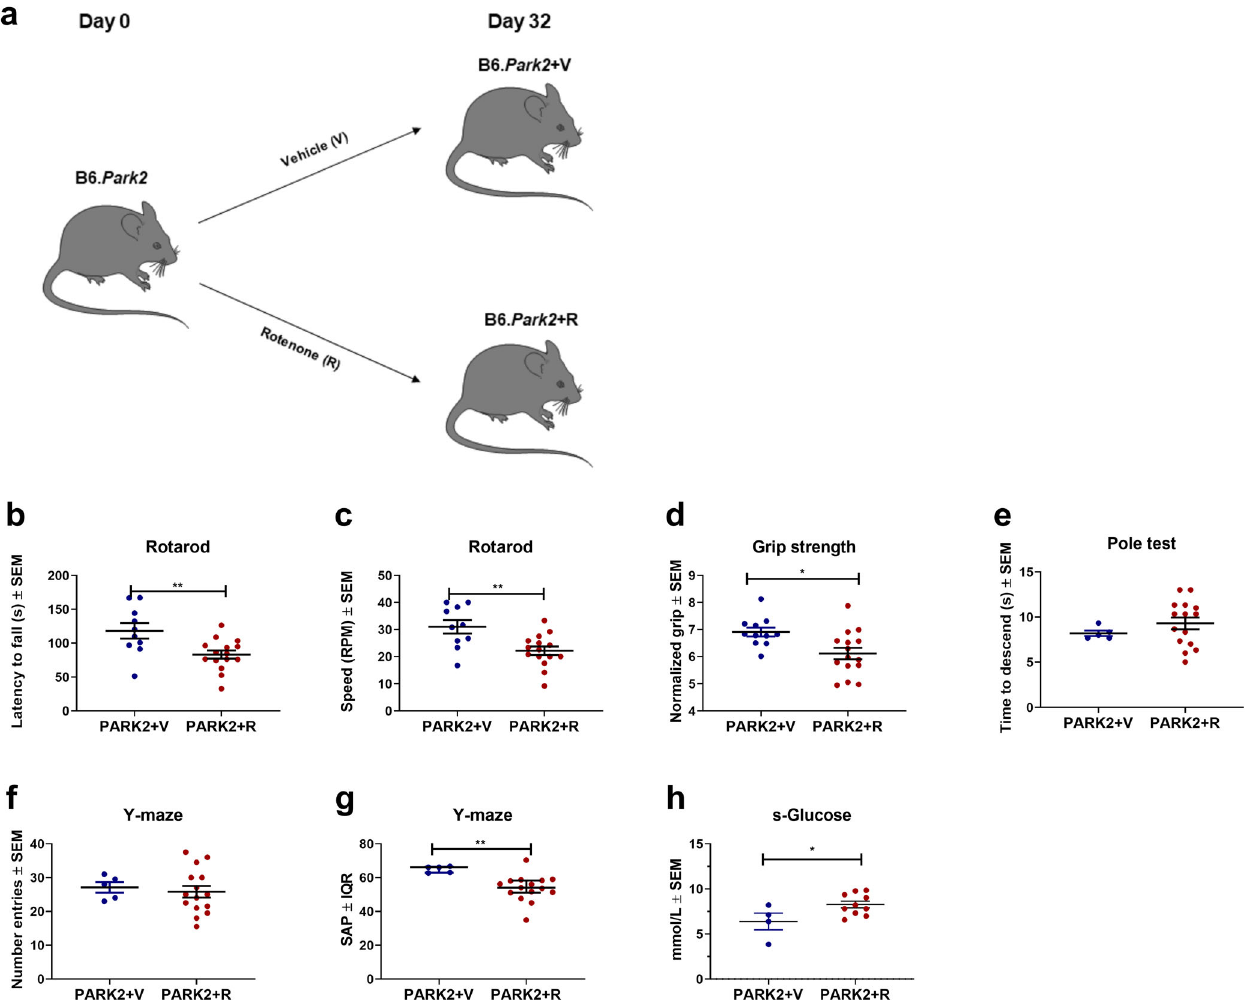
Fig. 7 Rotenone aggravates motor and non-motor dysfunction in PARK2 knockout mice. a Male PARK2 knockout mice were randomized into rotenone (30 mg/kg) exposure or vehicle (carboxymethylcellulose sodium salt, 0.5%) for 32 days. b Mean latency to fall of the rotarod ( n = 10 – 15). c Mean rounds per minute on the rotarod ( n = 10 – 15). d Mean normalized grip strength ( n = 11 – 15). e Mean time to descend the pole in the pole test ( n = 5 – 15). f Spontaneous activity in the Y-maze expressed as mean number of entries ( n = 5 – 15). g Visuospatial memory expressed as mean spontaneous alternation percentage in the Y-maze test ( n = 5 – 15). h Mean serum glucose levels measured in mmol/l ( n = 4 – 10). Animals were tested at day 32 and serum samples were obtained at day 32. Error bars represent the standard error of the mean (SEM). Data are representative of one experiment. Signi fi cant differences for behavior and serum experiments; * p ≤ 0.05; ** p ≤ 0.01; *** p ≤ 0.001; **** p ≤ 0.0001. PARK2 PARK2 knockout genotype, R rotenone, V Vehicle, SAP spontaneous alternation percentage. Center line = mean, and whiskers = standard error of the mean except for g , center line = median and whiskers = interquartile range. Statistics: two-tailed unpaired t -test. We acknowledge Servier Medical Art for the mouse illustration, with the following license: https://creativecommons.org/ licenses/by/3.0/. No changes were made to the